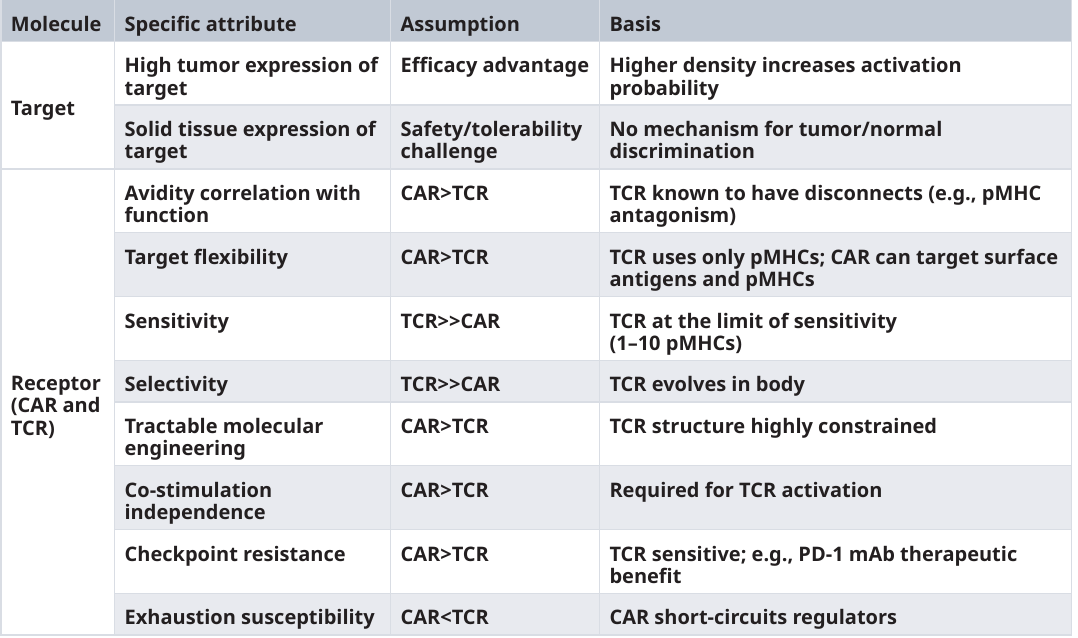
Table 1. Potential differences among cell therapy targets, receptors, and regulation not yet rigorously tested by mechanistic data. Experiments to test many of these assumptions are